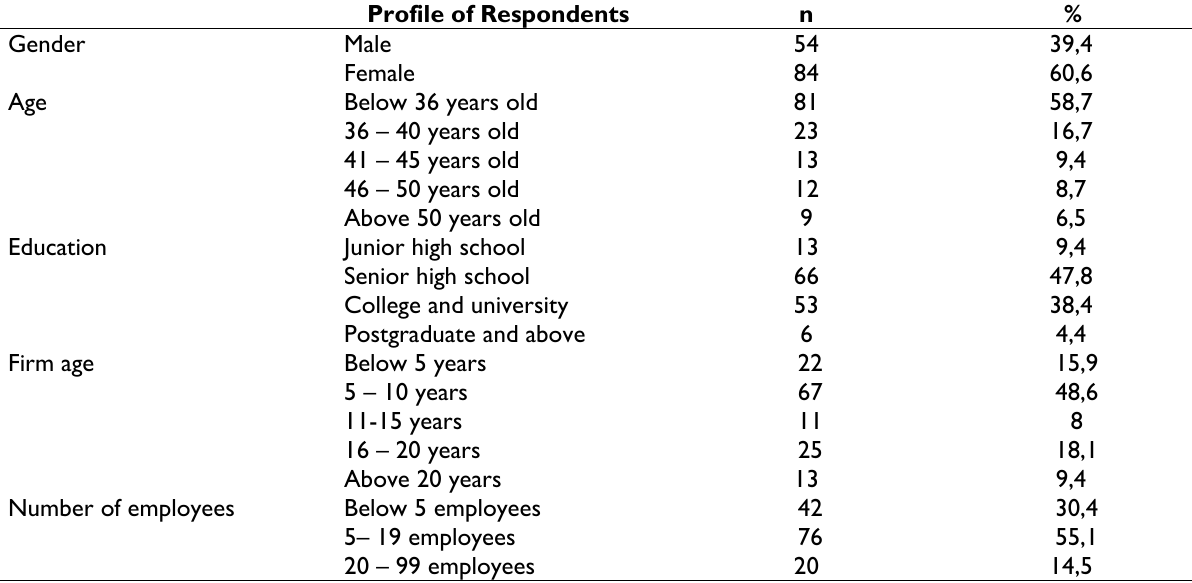
Table 2. Profile of